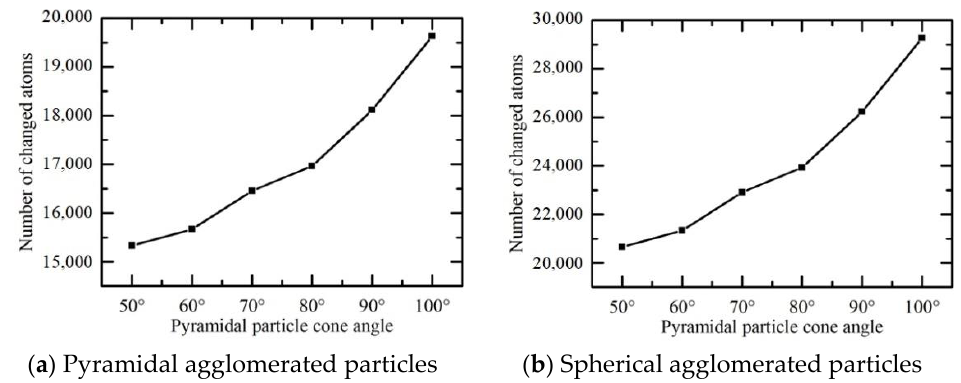
Figure 11. The number of atoms undergoing atomic structural change with agglomerated particles of different shapes and sizes.